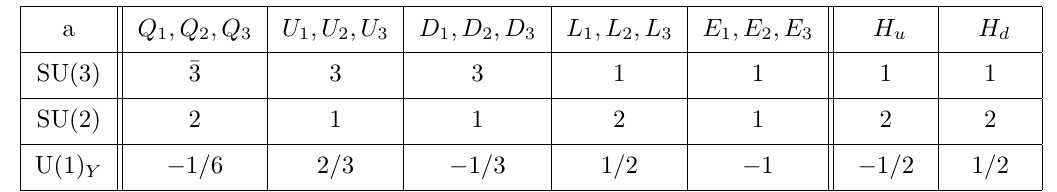
Table 1 . Chiral matter superfields in MSSM and their quantum numbers with respect to SU(3) × SU(2) × U(1) . The subscripts 1 , 2 , and 3 numerate generations.